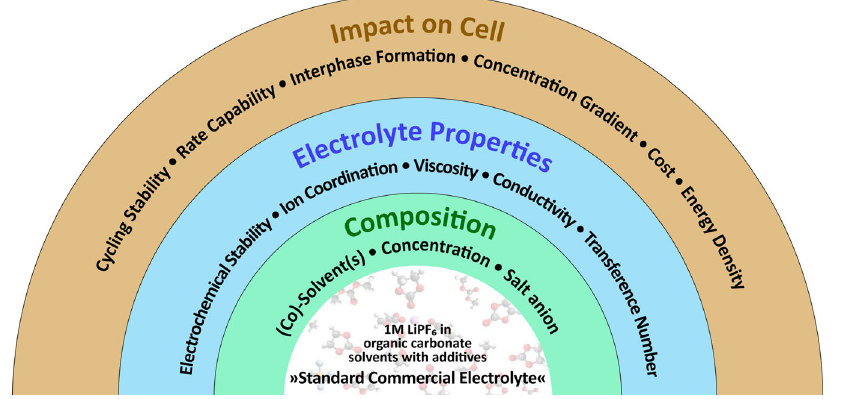
Fig. 1 | The electrolyte playing fi eld. In the middle of the fi gure, the standard commercial lithium-ion battery electrolyte solution is described. This standard electrolyte can be changed (green ring) not only by varying the composition (e.g.,